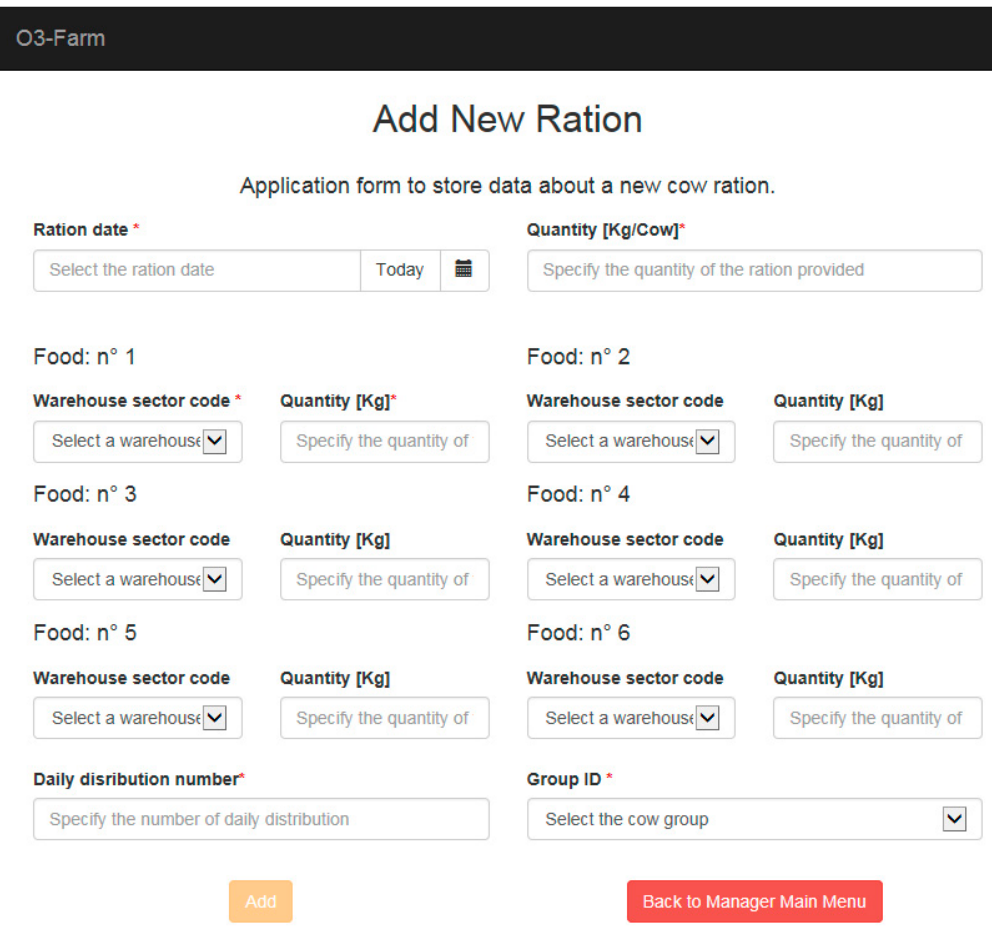
Figure 4. Manager sub-menu to add farming data.